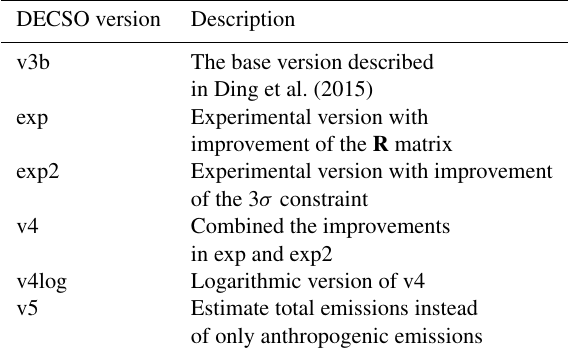
Table 1. Summary of main differences in various versions of